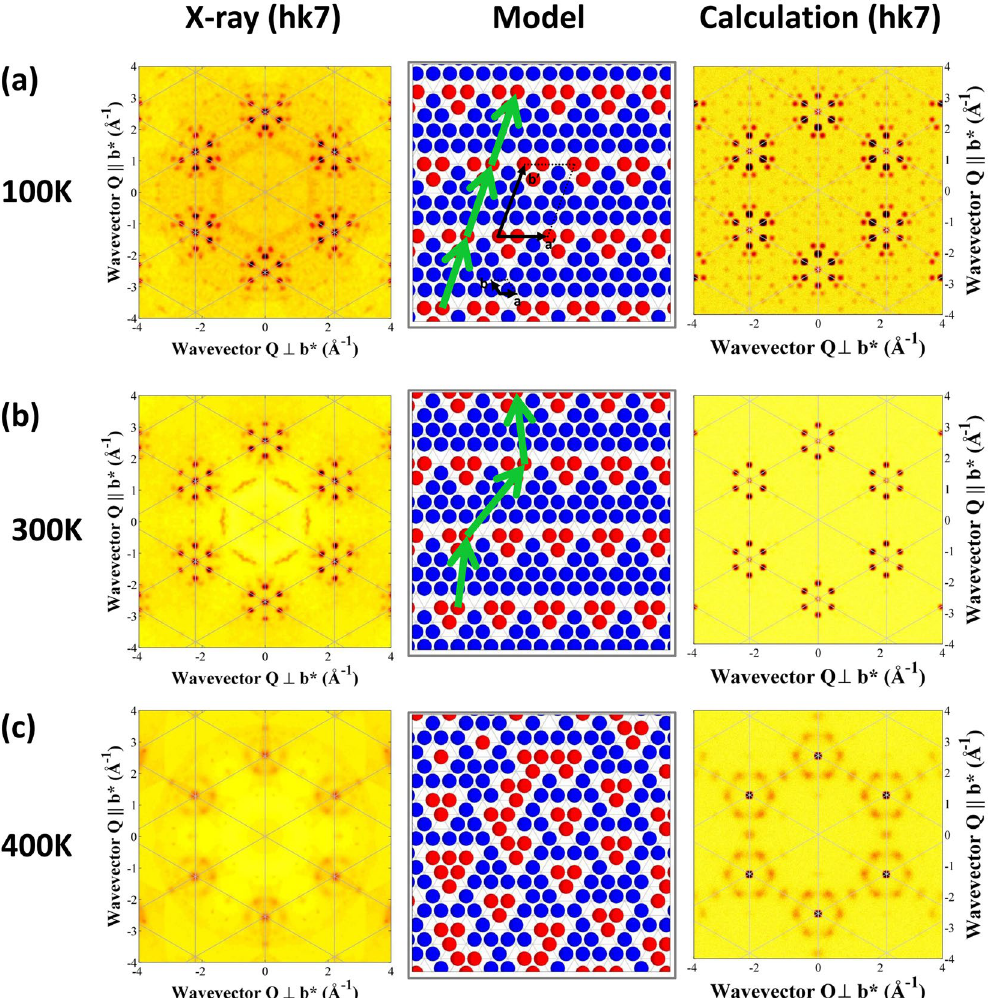
Figure 2. X-ray diffraction measurements of sodium ordering in Na 0.8 CoO 2 . ( a ) Long-range order in the fully ordered tri-vacancy stripe phase gives sharp superlattice reflections. A tri-vacancy cluster comprises three Na-ion vacancies and three Na ions promoted from 2 d (blue) to 2 b (red) sites. Hexagonal unit cell and supercell vectors are shown (black). Green vectors link equivalent sites in successive stripes. ( b ) In the partially disordered tri-vacancy stripe phase, the stripes are ordered long range, but the locations of the tri-vacancy clusters are not correlated between stripes, and there is a reduction in intensity of some of the higher order superlattice peaks. ( c ) In the disordered phase there are no sharp superlattice reflections, and the characteristic diffuse scattering pattern arises from short-range ordering of multi-vacancy clusters. The calculated intensities are from the supercell of the ordered tri-vacancy stripe phase 25 ( a ), a section of crystal with long-range ordering of stripes, but with random translations of the tri-vacancy clusters within stripes ( b ), and from a Monte Carlo simulation of a disordered mixture of di-, tri- and quadri-vacancy clusters ( c